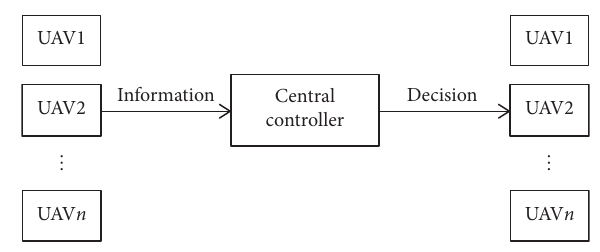
Figure 1: Centralized control structure.